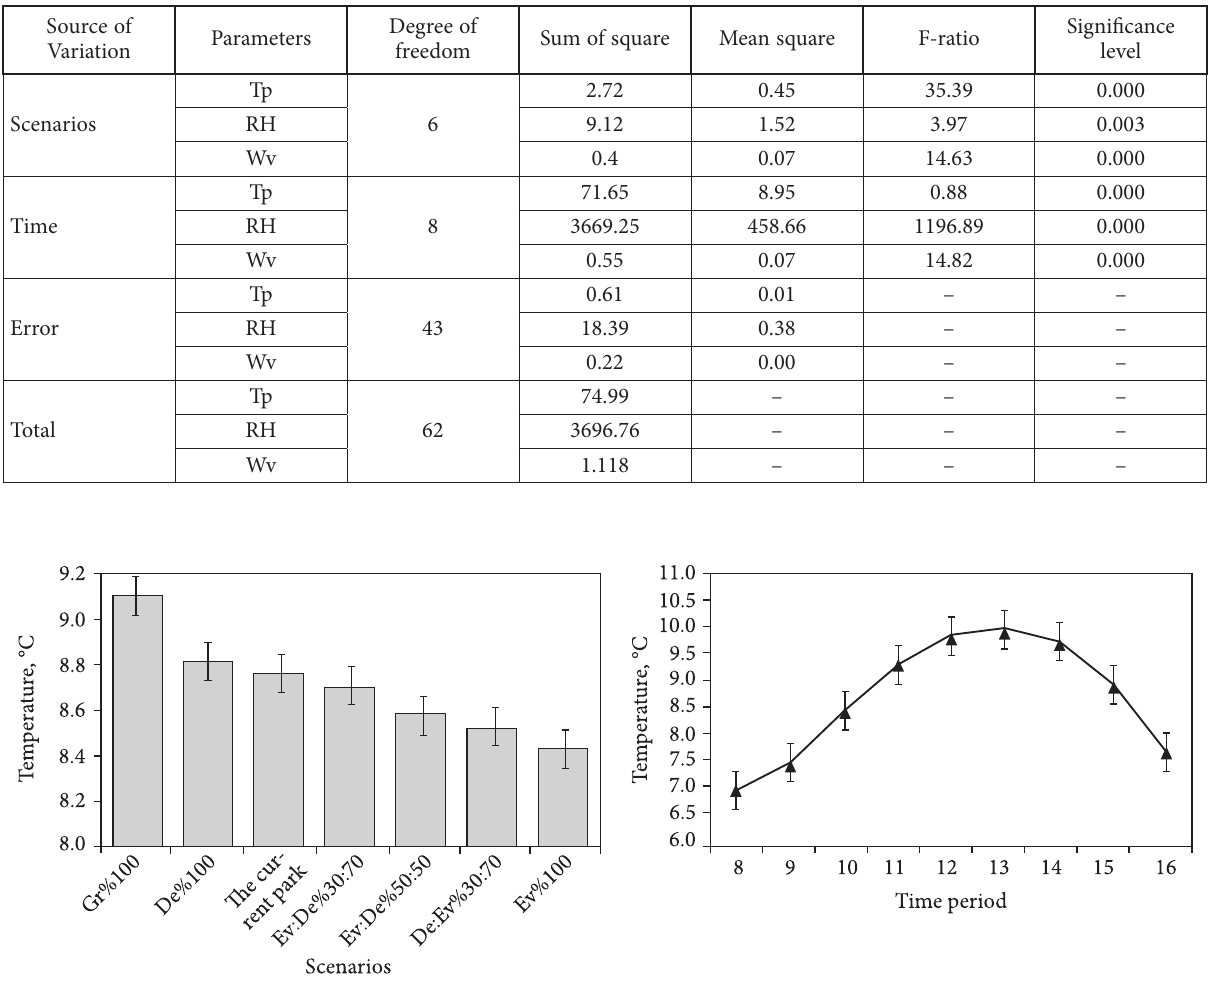
Figure 4. Comparison of temperature in the various simulated scenarios and in the period time (08:00–16:00)